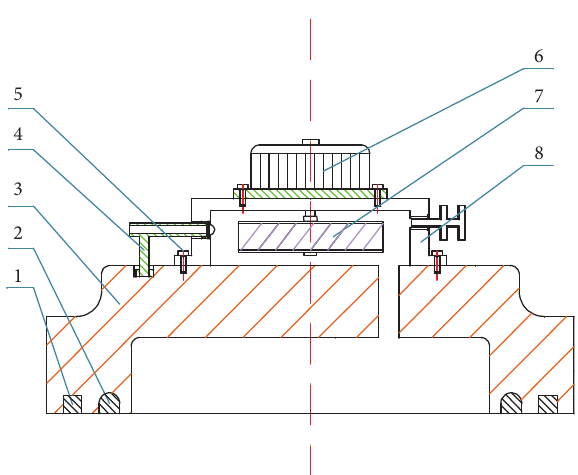
Figure 7: Negativepressureadsorptionmechanismofintelligentsafety monitoring robot for shaft construction. (1) Sealing ring 1; (2) sealing ring 2; (3) adsorption disc; (4) air outlet; (5) set bolt; (6) adsorption motor; (7) impeller; (8) shell.